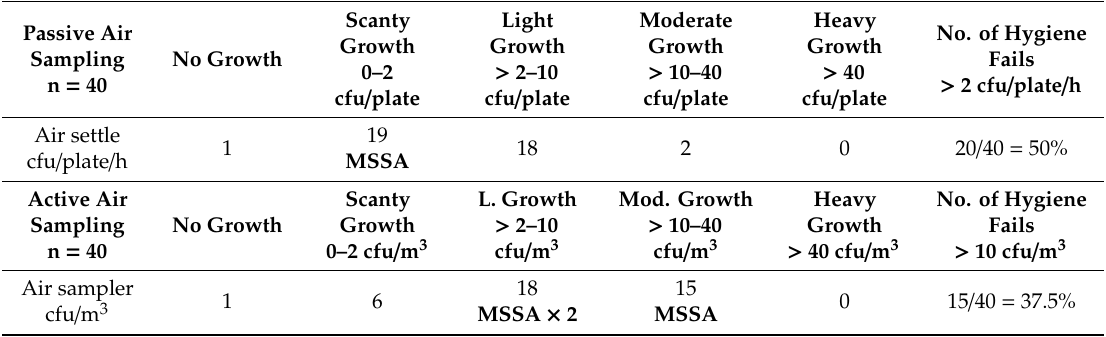
Table 2. Microbial burden categories for air (active and passive sampling) and hygiene fails according to